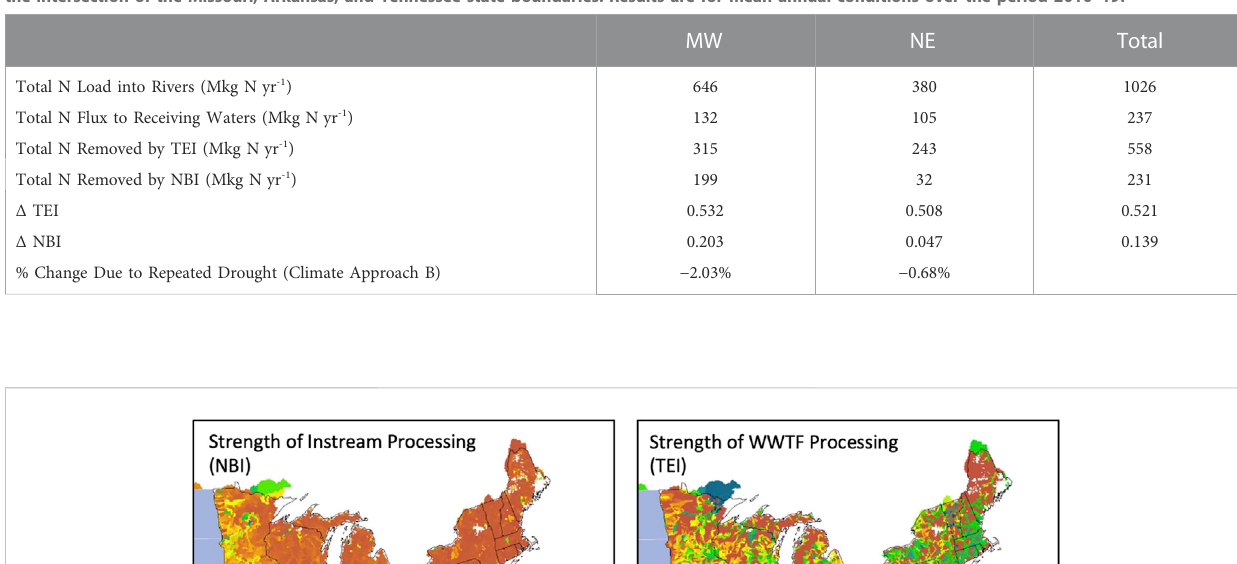
extreme alone plus the two climate-technology scenarios all generated negative impacts on overall regional power production, with the coal fuel scenario showing the lowest potential production and, as with Approach A, an approximate 10% penalty. The bars on the right side of Figure 4C are the Δ values showing that in our example electricity production was reduced under all scenarios but by less than 5%. The CoolT scenario, in contrast, showed but a 1%